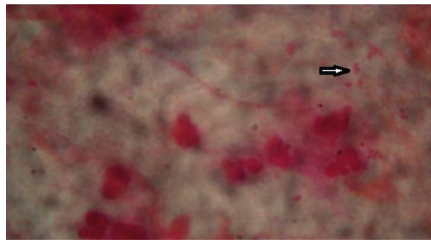
Figure 1: Gram-stained smear showing pus cells and Gram- negative M.